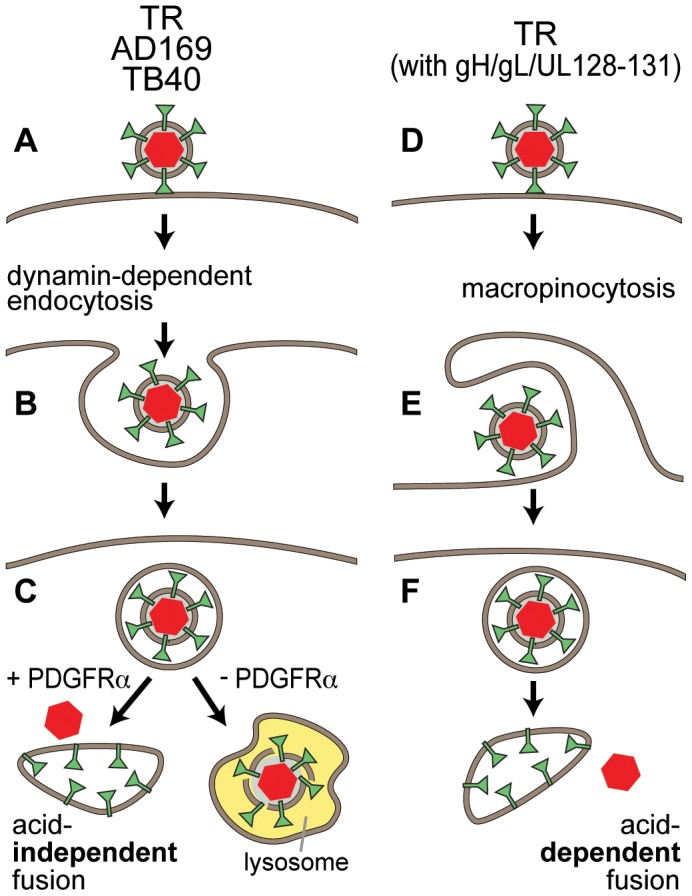
Models of HCMV entry pathways.
A–C). HCMV TR, AD169 and TB40 are all taken up by dynamin-dependent endocytosis. If cells are induced to express increased PDGFRα, virus particles can fuse with endosomes by a low pH-independent mechanism, so that capsids enter the cytoplasm and can initiate infection after moving to nuclear pores. Without increased PDGFRα virus particles are degraded, presumably following delivery to lysosomes. D–F). Wild type HCMV TR particles which contain gH/gL/UL128–131 can also be taken up by macropinocytosis into endosomes. There is low pH-dependent fusion with endosomal membranes delivering capsids into the cytoplasm. It remains possible that AD169 and TB40 are also taken up by macropinocytosis but cannot exit endosomes derived from this process.